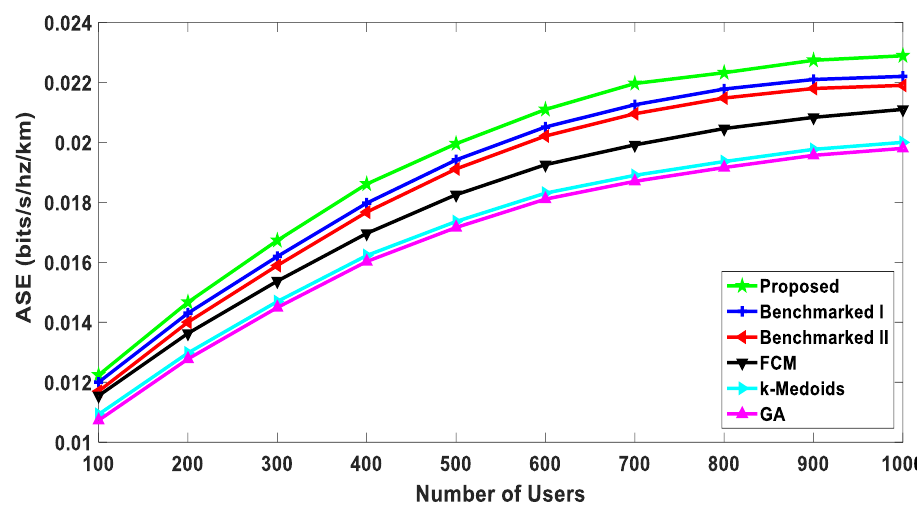
Figure 11. Cumulative Distribution Function (CDF) of energy consumption ( 𝑤 1 = 0.4,𝑤 2 = 0.6 ).